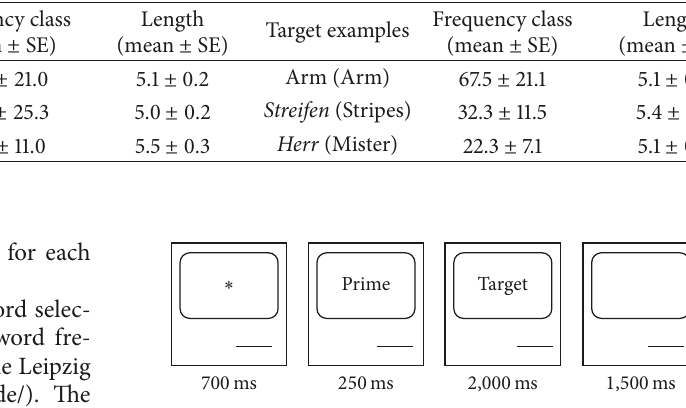
Table 2: Types and number of conditions (prime-target relations) used in the experiment.